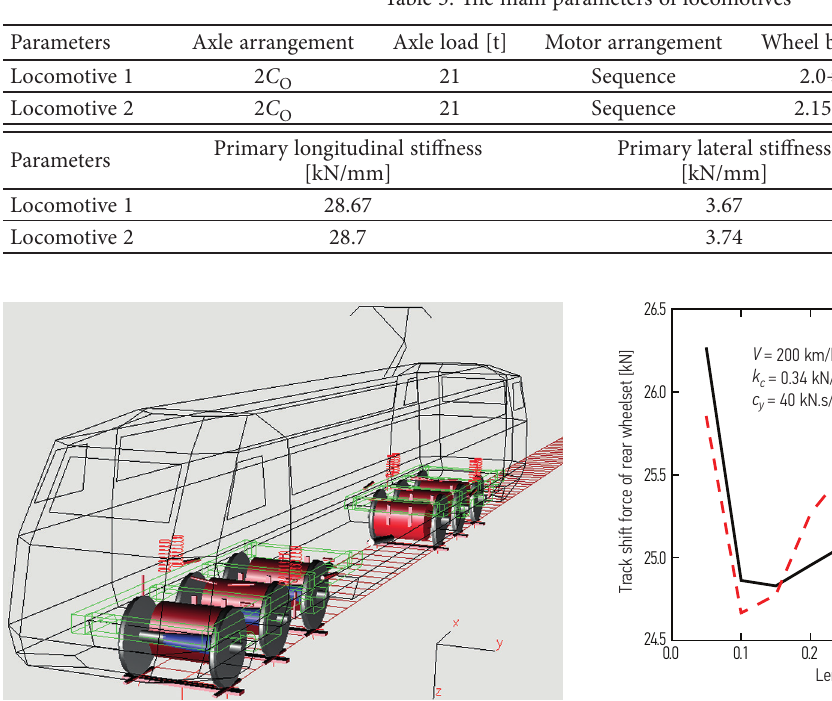
Fig. 22. The simulation results of locomotive 1 when the k c is 0.34 kN/mm